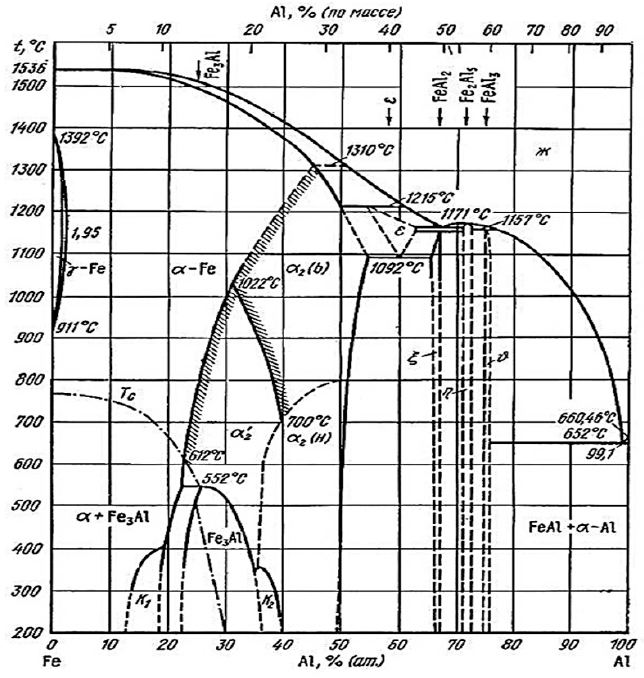
Figure 6. Fe-Al Binary phase diagram [33].